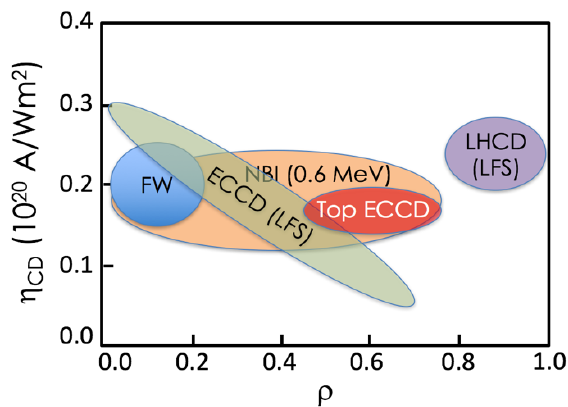
Figure 1: Cartoon illustration of current drive efficiency of various current drive methods: NBI at 0.6MeV (0.6MeV used here as an average of beam voltages used in various future device studies; LHCD (conventional LFS launch); Fast wave; ECCD (conventional LFS launch) and Top launch